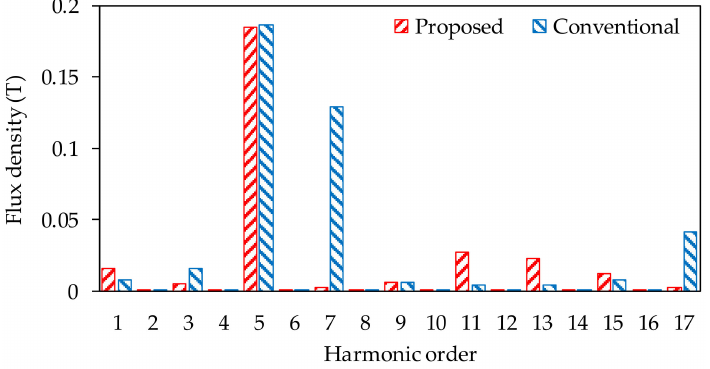
Figure 14. Spectra of the air gap flux densities of the armature reaction fields of the two compared machines.